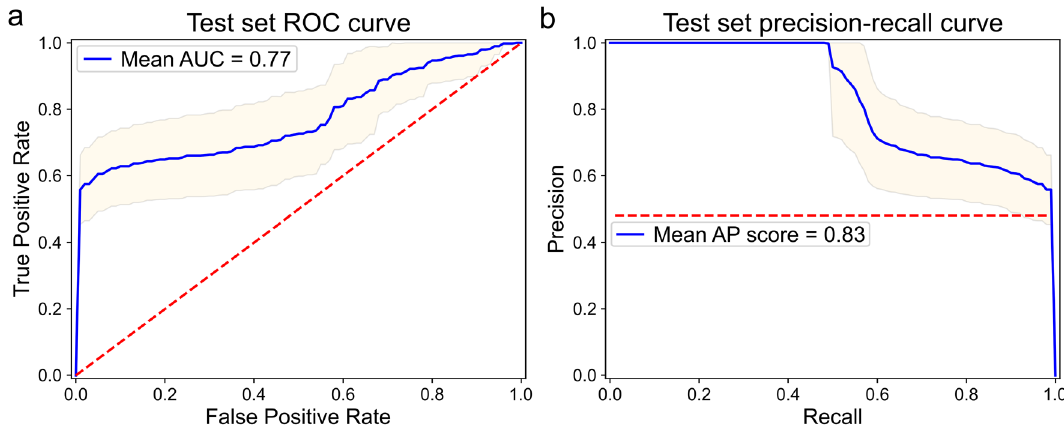
Figure 4. Interpretation of binary classification performance on hold-out test set. ( a ) Mean ROC curve (blue) and variance (yellow) of the 10 models from condition 4 (see Table 2) evaluated on the test set. For multiple thresholds, the true positive rate (TPR, also known as recall) is studied against the false positive rate (FPR). Dotted red line indicates a no-skill classifier. Mean AUC under ROC is reported. ( b ) Mean precision-recall curve (blue) and variance (yellow) of the 10 models from conditions 4 (see Table 2) evaluated on the test set. For multiple thresholds, the precision is studied against the recall (TPR). Dotted red line indicates a no-skill classifier. Mean average precision (AP) score is reported. The graphs explain performance with different metrics, and indicate no detriment in test performance due to imbalanced